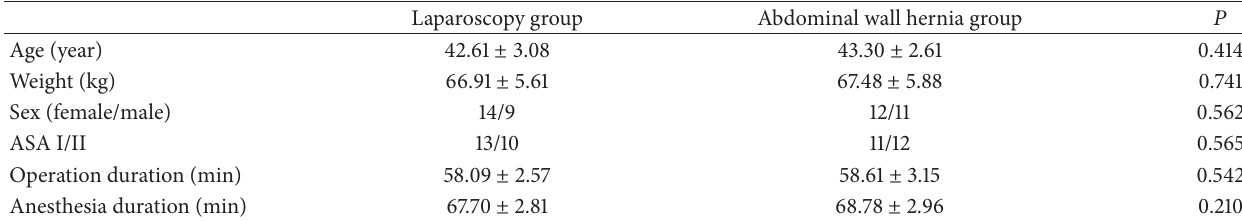
Table 1: Clinical characteristics of the patients and operation-anesthesia durations of groups.